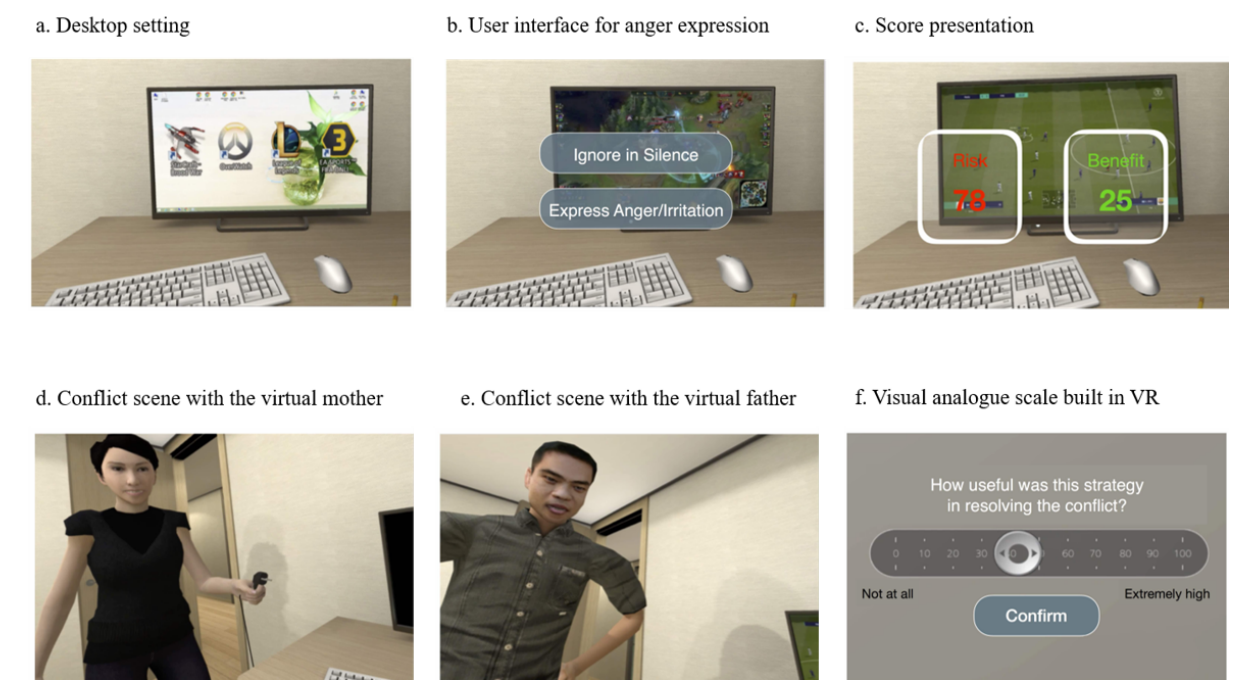
Figure 2. Screenshots of the virtual environment. VR: virtual